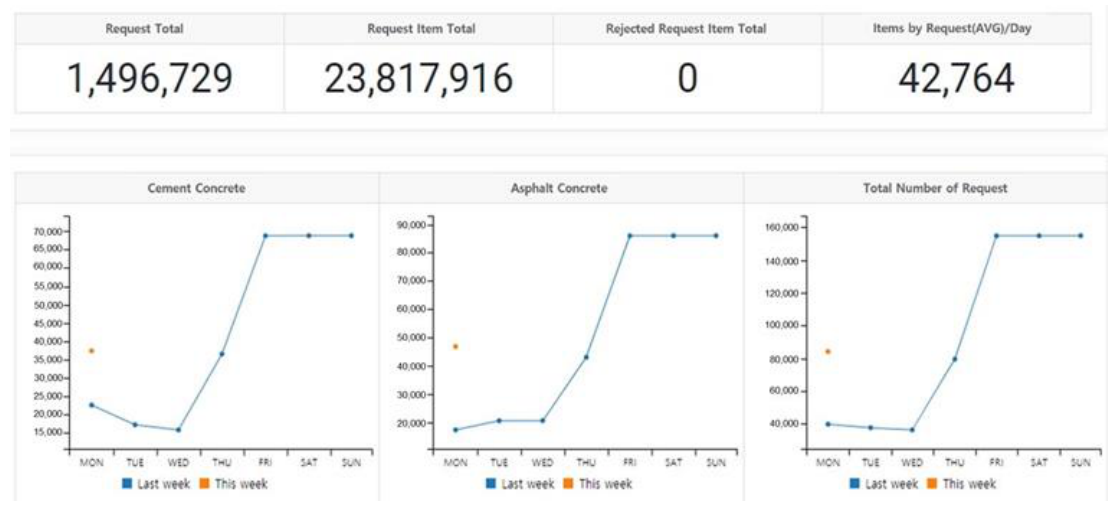
Figure 6. Interface API implementation.